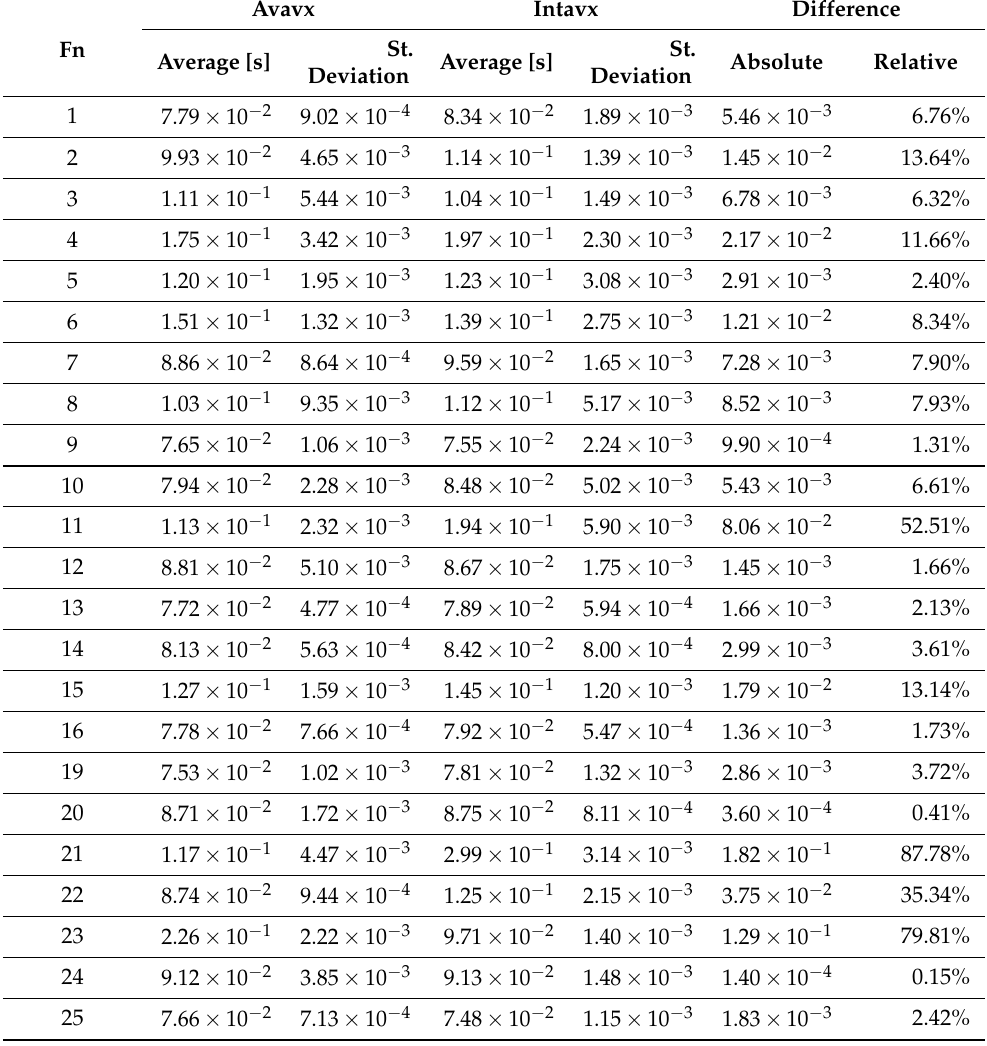
Table 4. PSO runtime performance on the test suite: 128 dimensions, 32 particles. Avavx Intavx Difference St. St. Fn Average [s] Average [s] Absolute Deviation Deviation